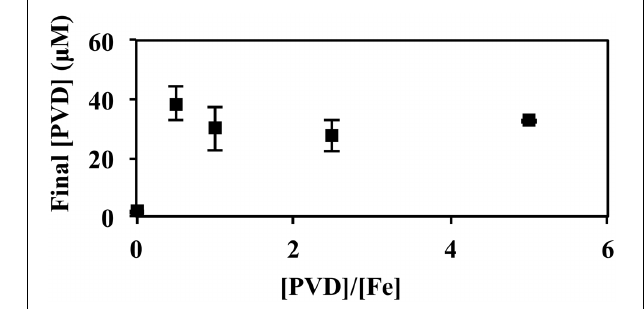
FIGURE 6 | Concentration of PVD present 2 days after the addition of various exogenous PVDs to each of four different siderotype n ◦ 1-producing strains: P. putida GB-1 (open), P. putida CFML90-49 (horizontal lines), P. putida MnB1 (dots), and P. putida BC (vertical lines). [Fe(III)] = 2 μ M (added as FeCl 3 ) and added [PVD] = 10 μ M. Error bars indicate the standard deviation of triplicate samples.